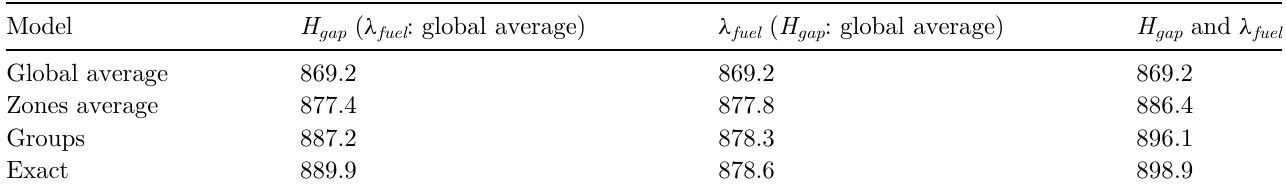
Table 1. Comparison of sodium maximal temperature ( ° C) during ULOF/PP accident for different thermal properties models.